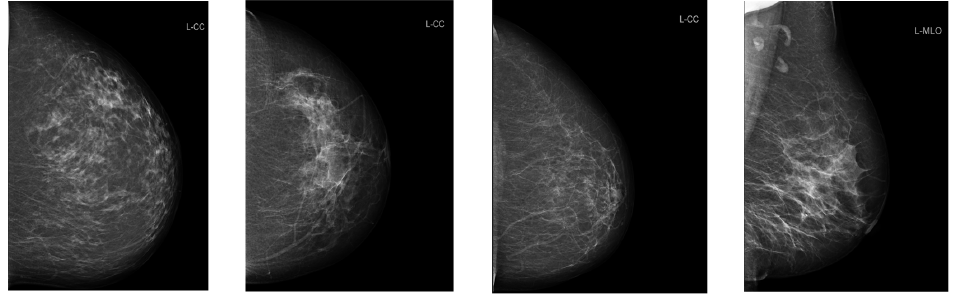
Figure 2. In the picture there are BAC examples from grade 1 ( a ) until grade 4 ( d